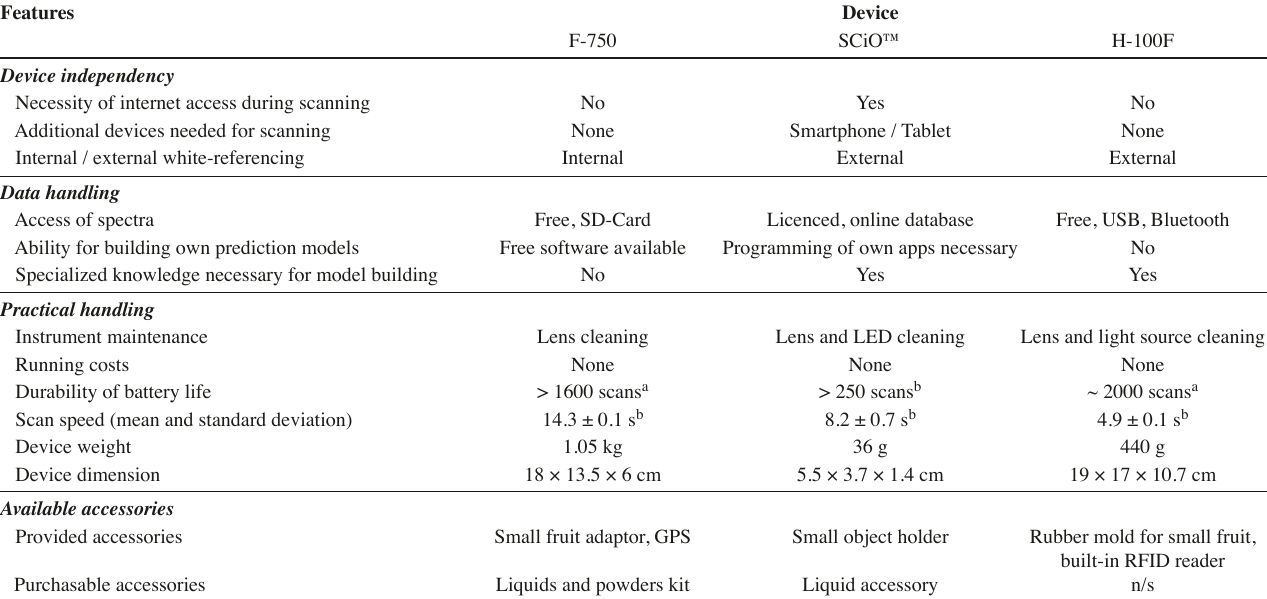
Tab. 5: Compilation of food-scanner characteristics with respect to usability and applicability